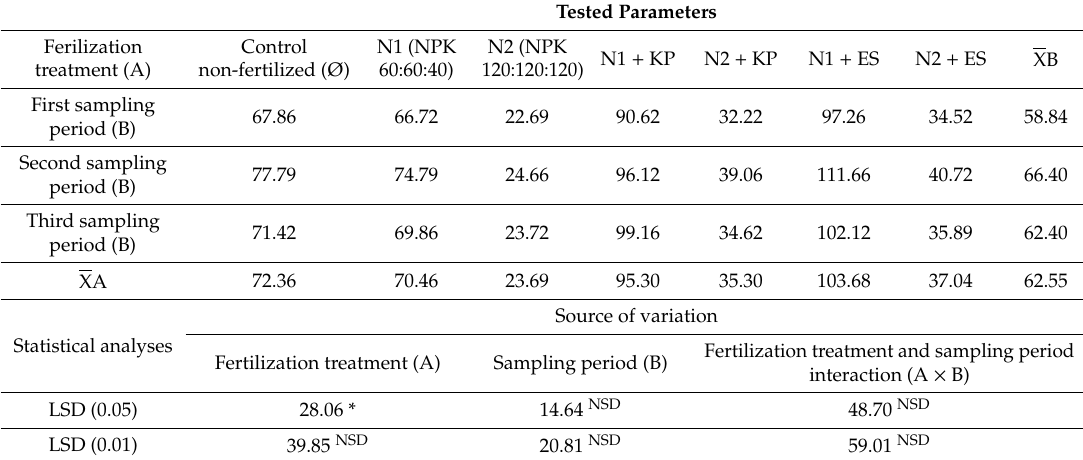
Table 6. E ff ect of the fertilization treatment (A), sampling period (B), and fertilization treatment and